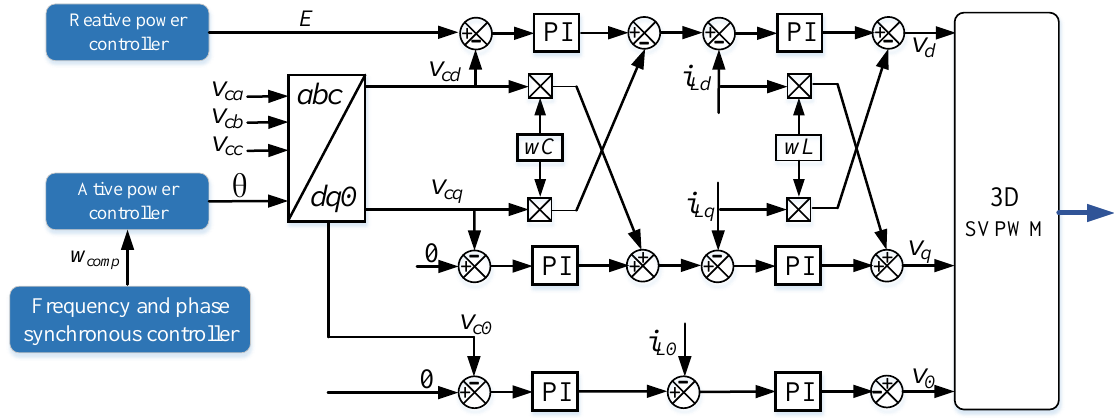
Figure 15. Control structure of the renewable energy